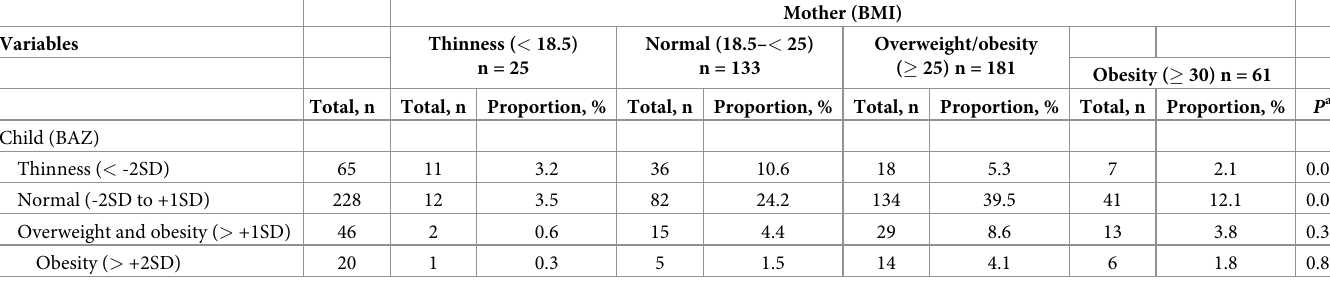
Table 2. Distribution of nutritional status among mother-child pairs in urban Sri Lanka (n =